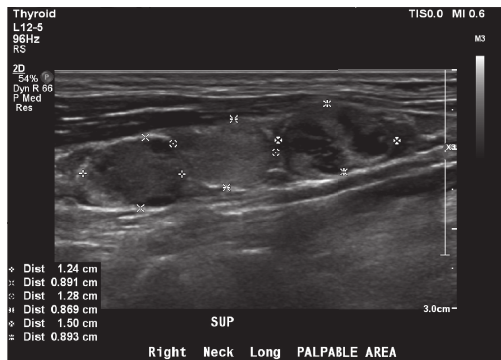
Figure 2: Ultrasound transverse image of lymphadenopathy in the right cervical area with distortion of normal morphology and cystic